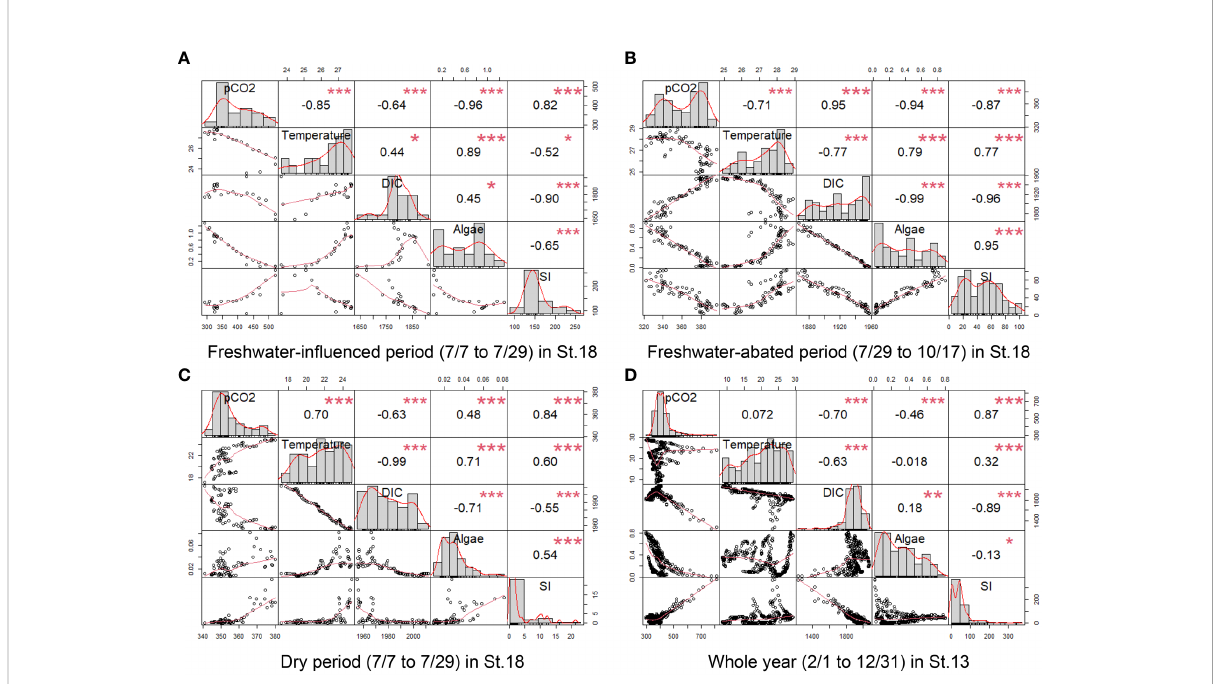
FIGURE 7 Multiple linear regression (Pearson ’ s correlation coef fi cients and p -values) (* p ≤ 0.05, ** p ≤ 0.01, *** p ≤ 0.001) at different periods of St.13 (D) and St.18 (A – C) . The items involved in the analysis were pCO 2 , water temperature, salinity, DIC, TA, algae, and